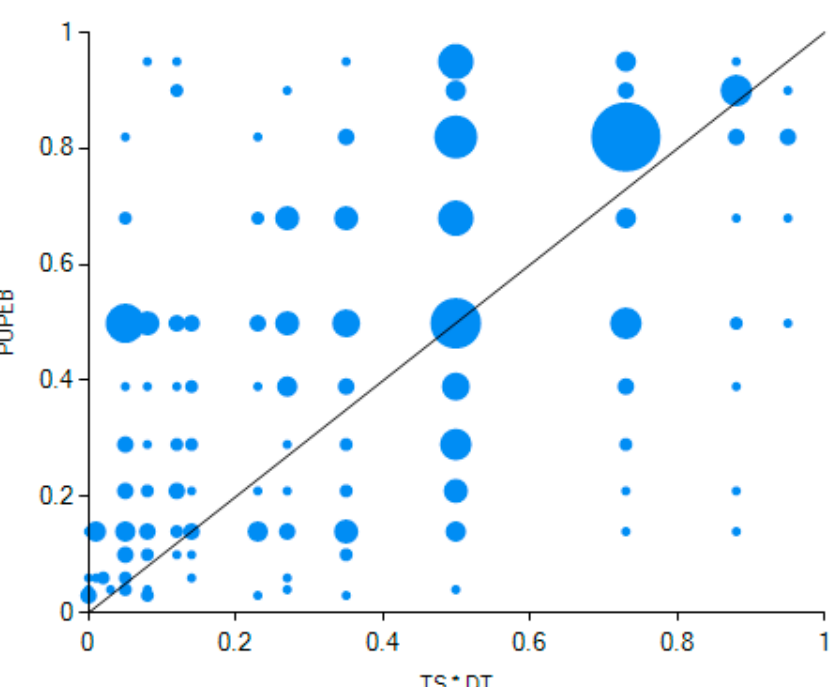
Figure 5. Explanation example of configuration 1 in the public pro-environmental behavior mode.